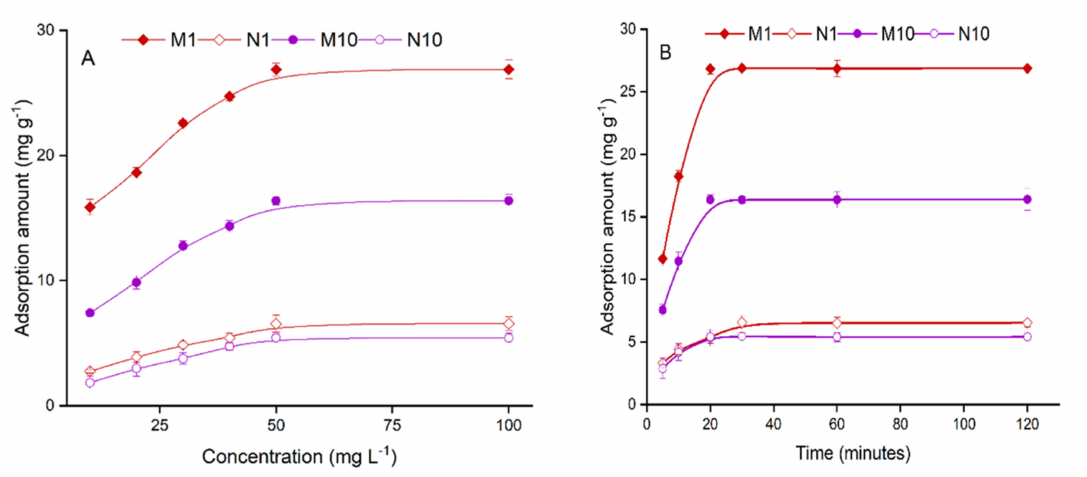
Figure 4. ( A ) Isothermal binding of the polymers (adsorption time: 30 min), ( B ) Kinetic adsorption of the polymers (concentration: 50 mg L − 1 , temperature 25 ◦ C). Table 2. Langmuir, Freundlich isotherms models and Pseudo-second-order parameters for the binding of FNT on MIPs and NIPs. Langmuir Isotherm